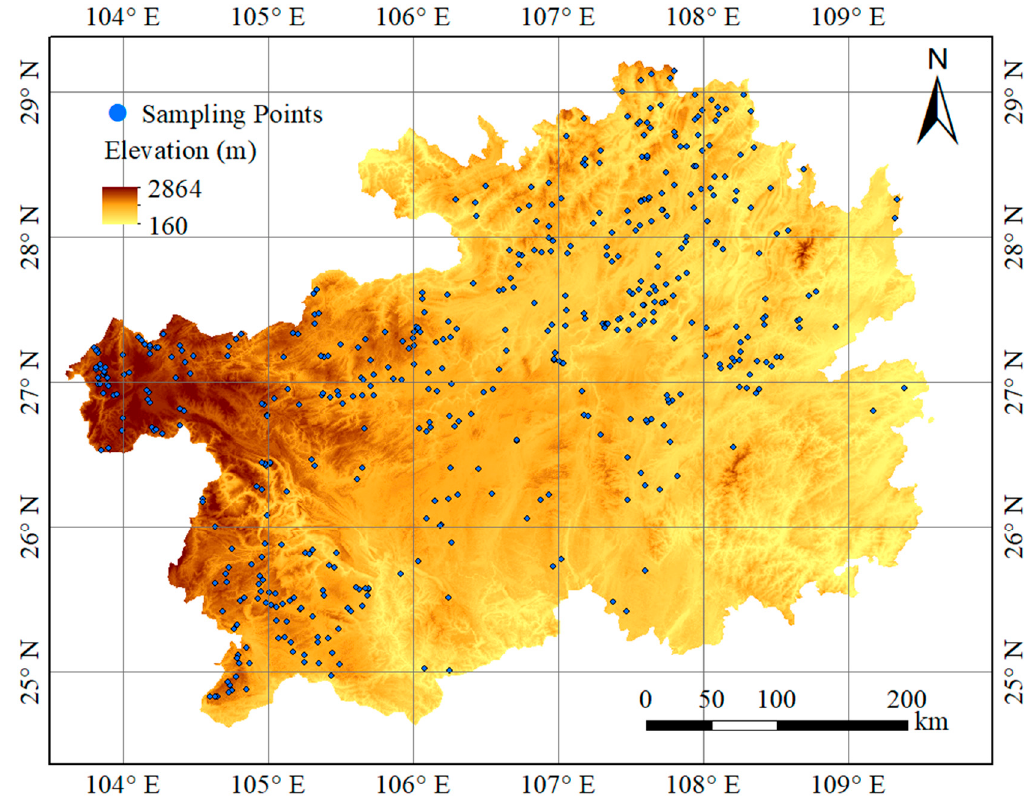
Figure 1. Distribution of sampling points.